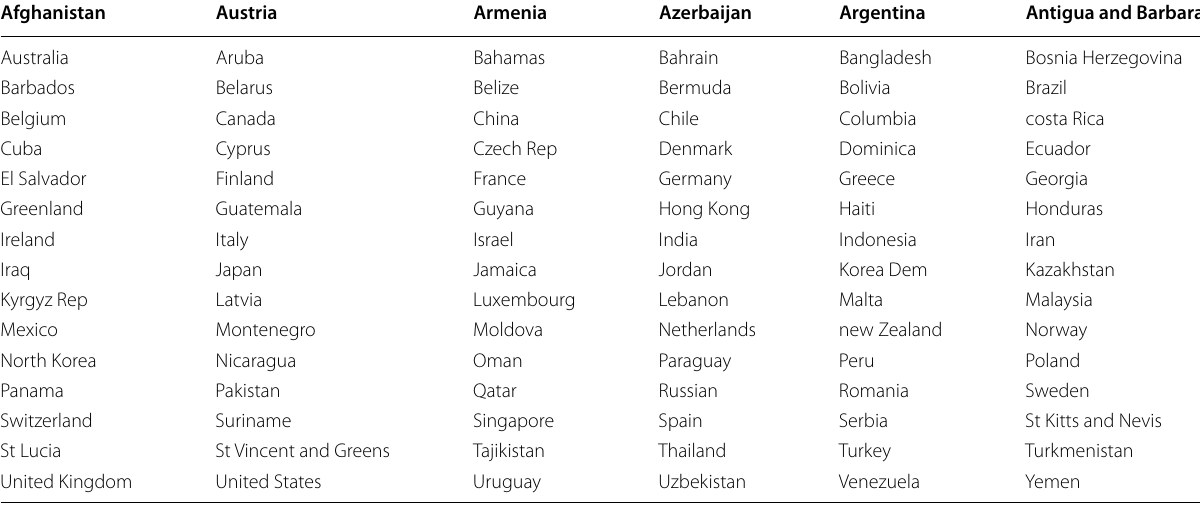
Table 8 The List of 96 Selected Trading Countries with Africa. Source (IMF, 2020) Afghanistan